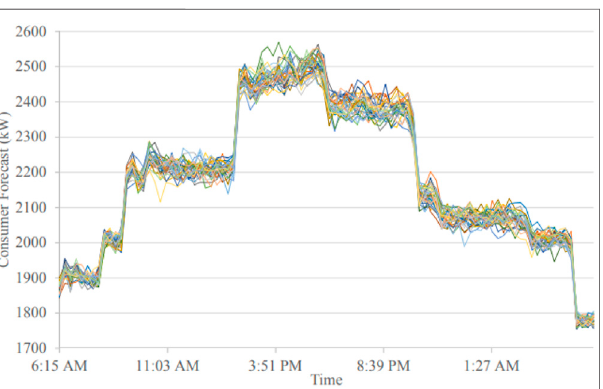
FIGURE 5 | Three utility